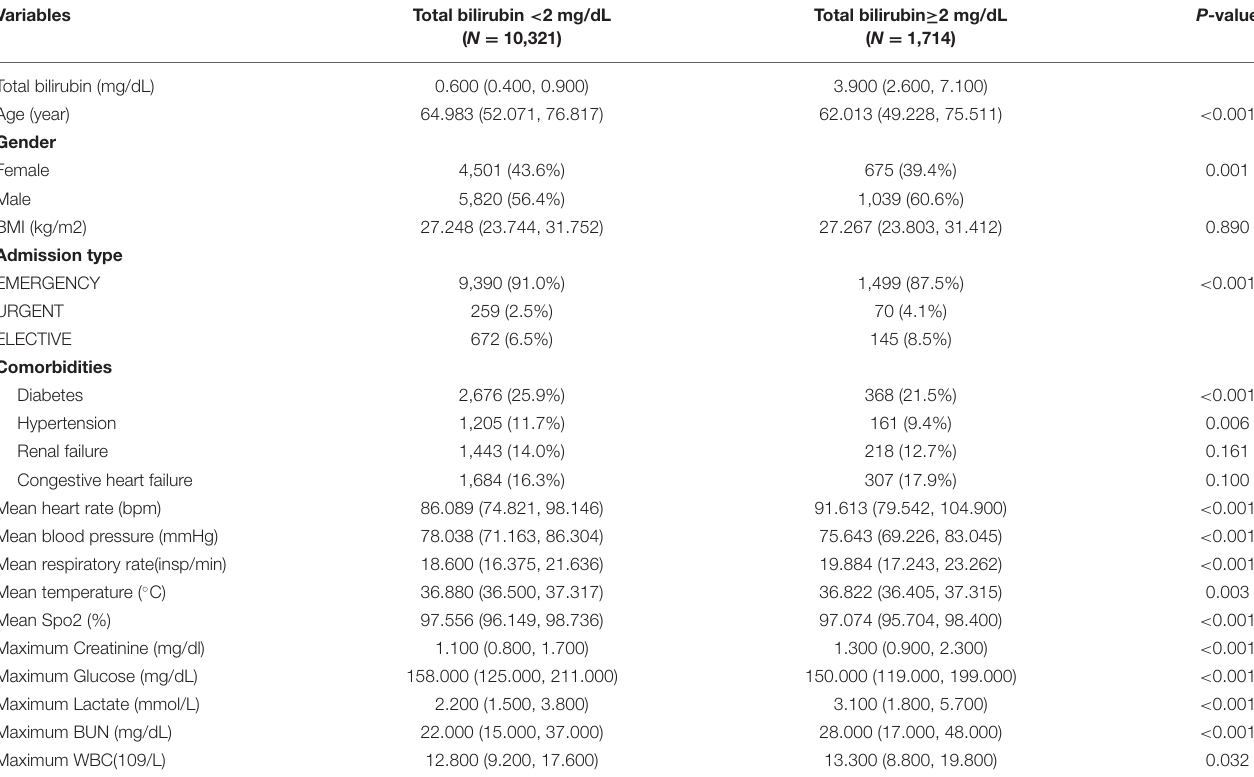
TABLE 1 | Baseline characteristics of critically ill patients involved in the study. Variables